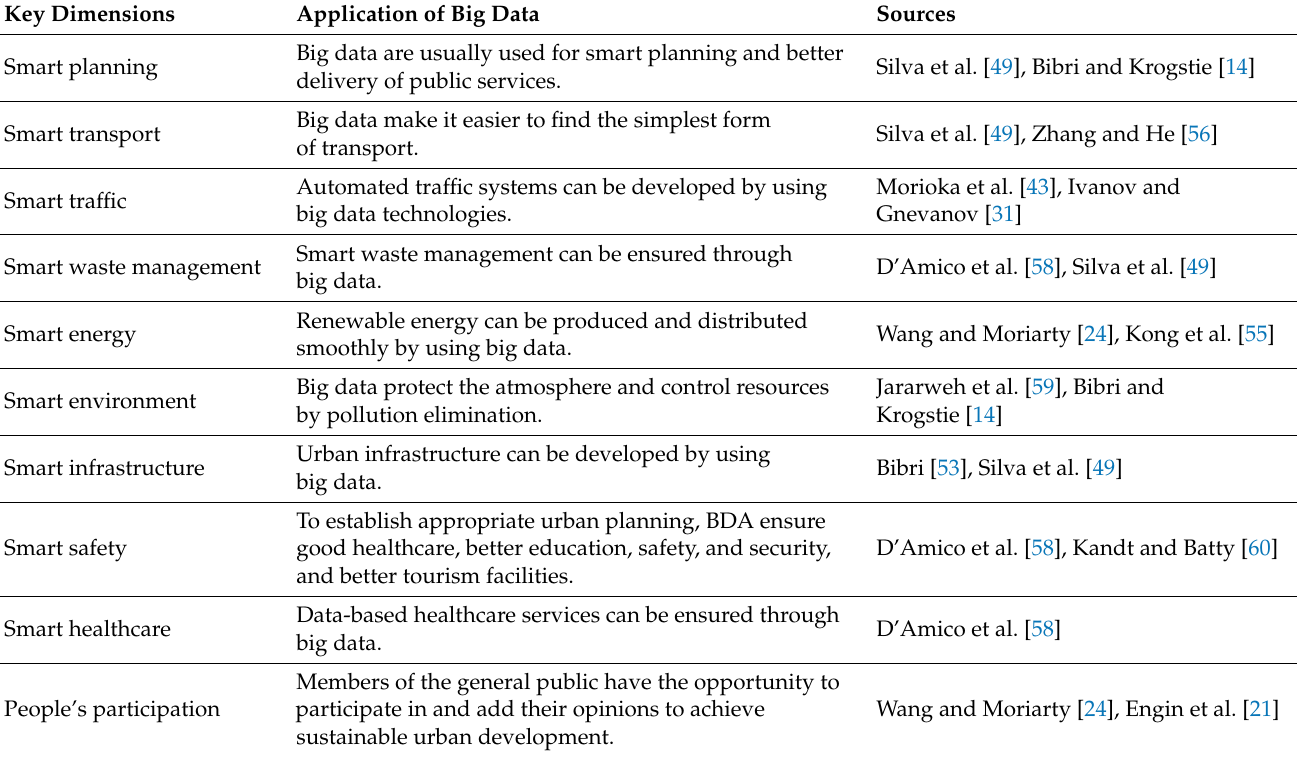
Table 6. Role of BDA in sustainable urban